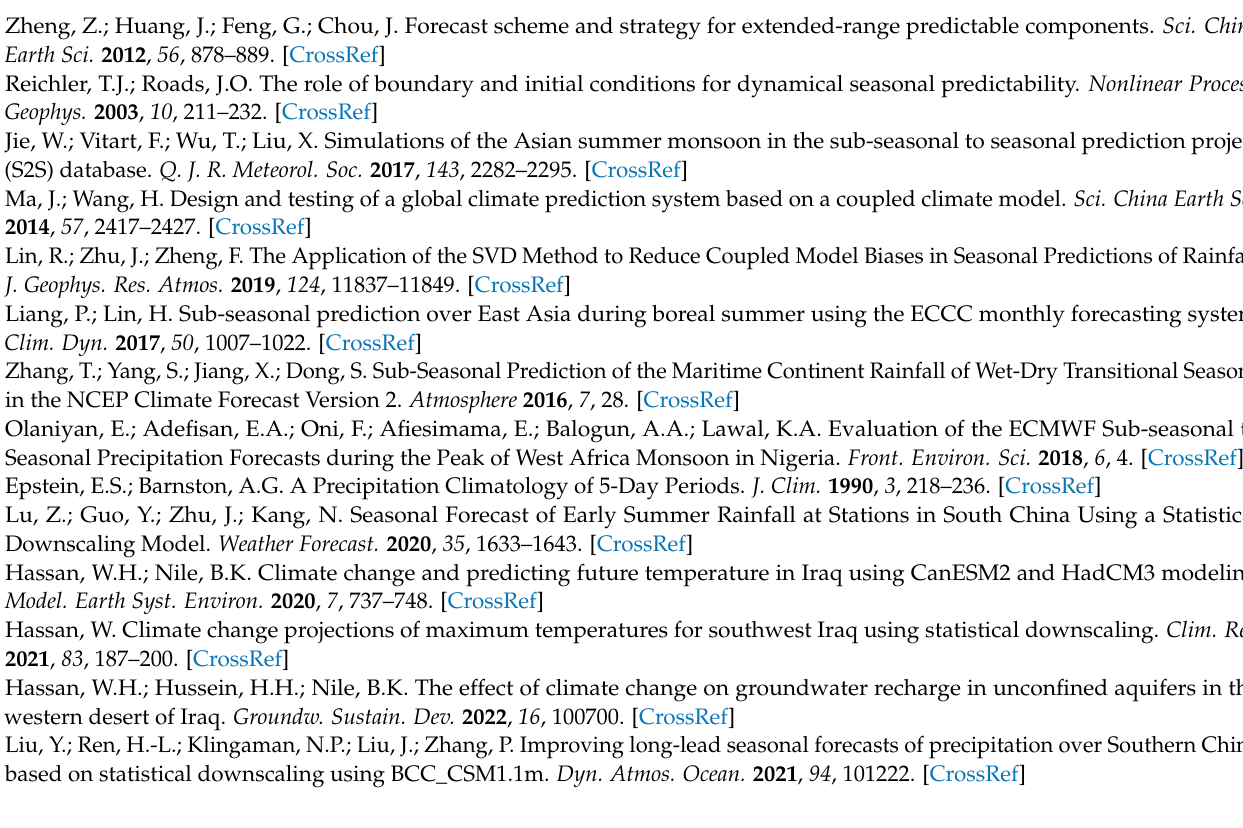
Figure A1. Prediction of the Z500 anomalies using the ( a ) third pentad of July 2021 (11–15 July), ( b ) fourth pentad of July 2021 (16–20 July) and ( c ) fifth pentad of July 2021 (21–25 July).